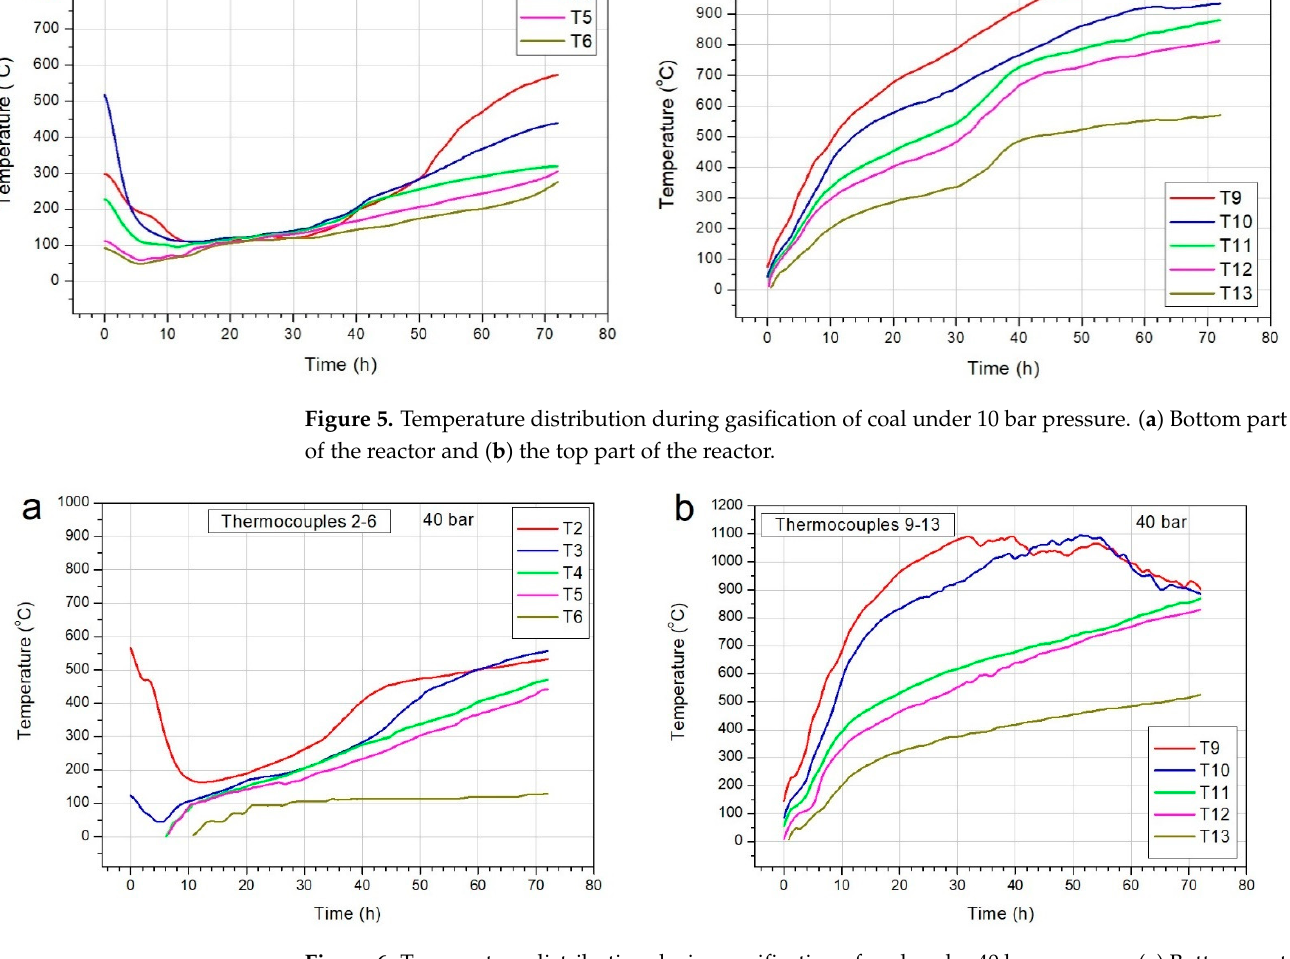
Figure 6. Temperature distribution during gasification of coal under 40 bar pressure. ( a ) Bottom part of the reactor and ( b ) the top part of the reactor .